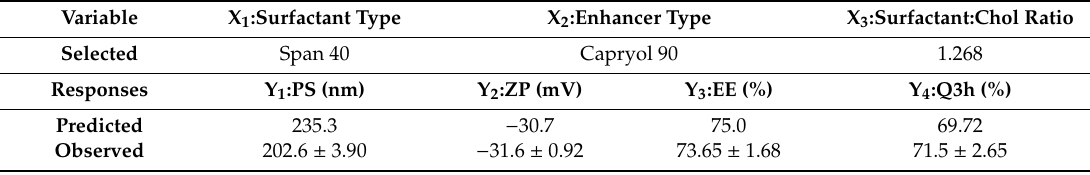
Table 3. The optimized variables, the predicted, and the observed responses of the optimal